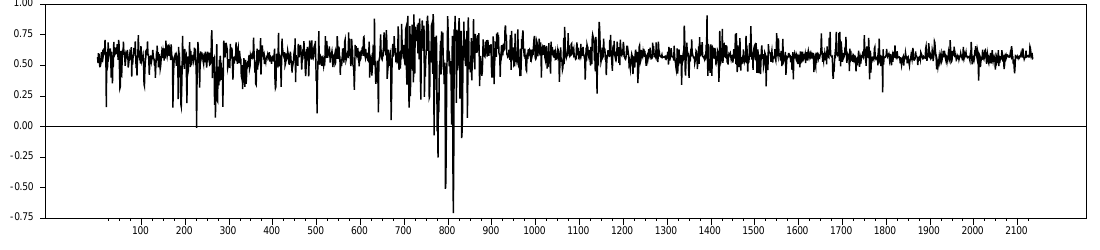
Fig. 3. Dynamic conditional